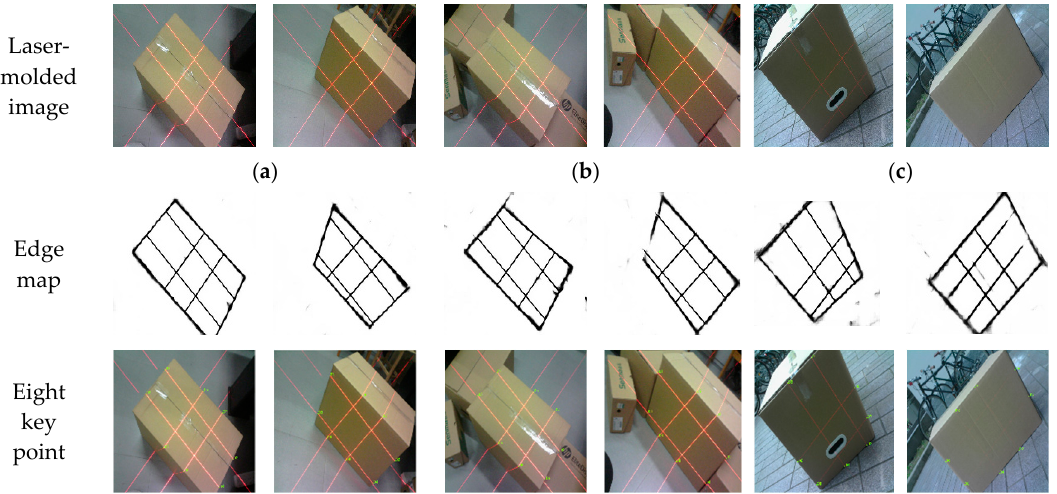
Figure 16. Image processing and key point extraction by our algorithm; ( a ), ( b ) and ( c ) are the measured images captured by our device.